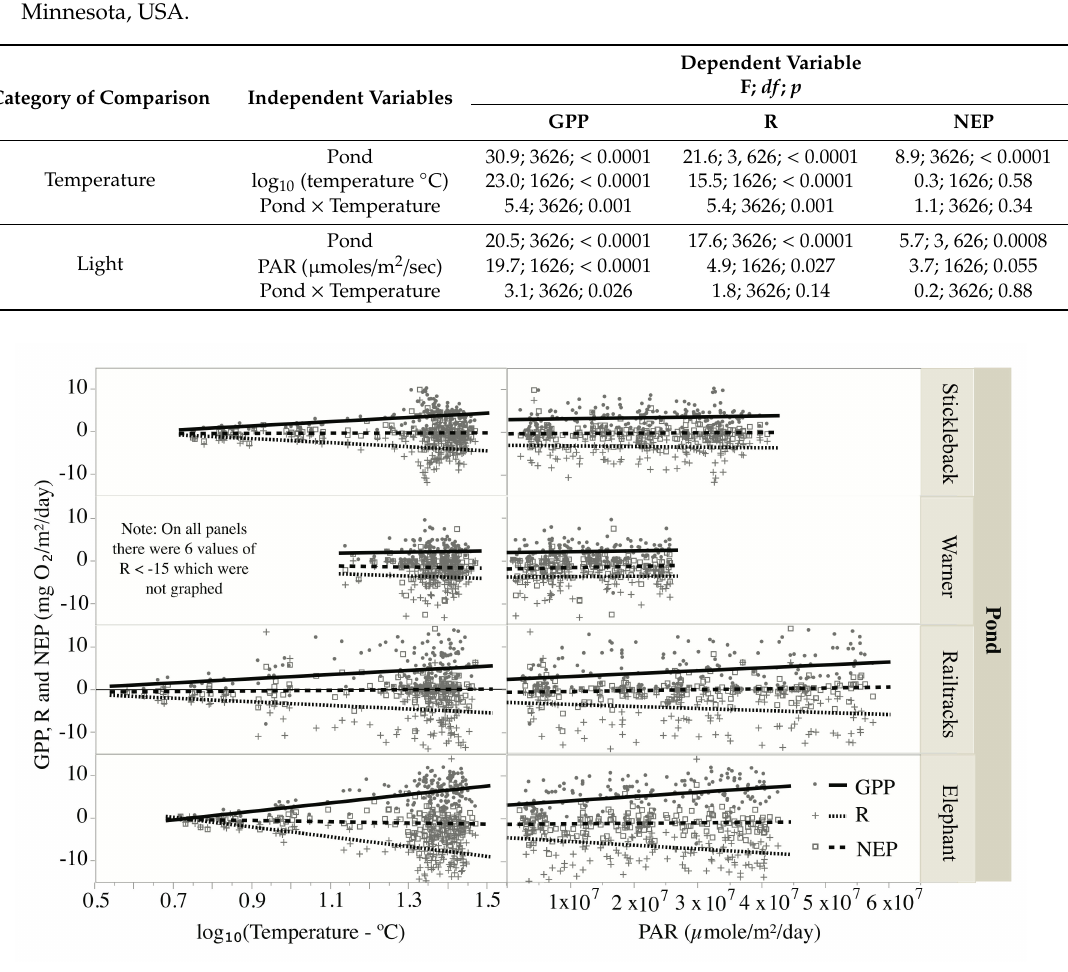
Figure 11. E ff ects of water temperature and light (PAR) on measures of ecosystem metabolism, (GPP, R and NEP) for four ponds in east-central Minnesota,